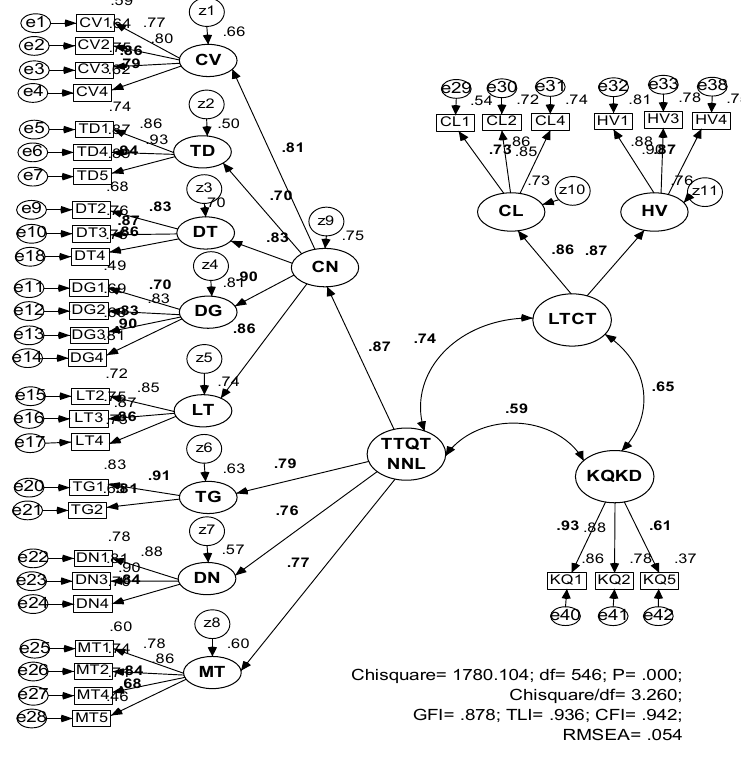
Fig. 5. CFA results of the saturated model Source: Author’s estimation from survey